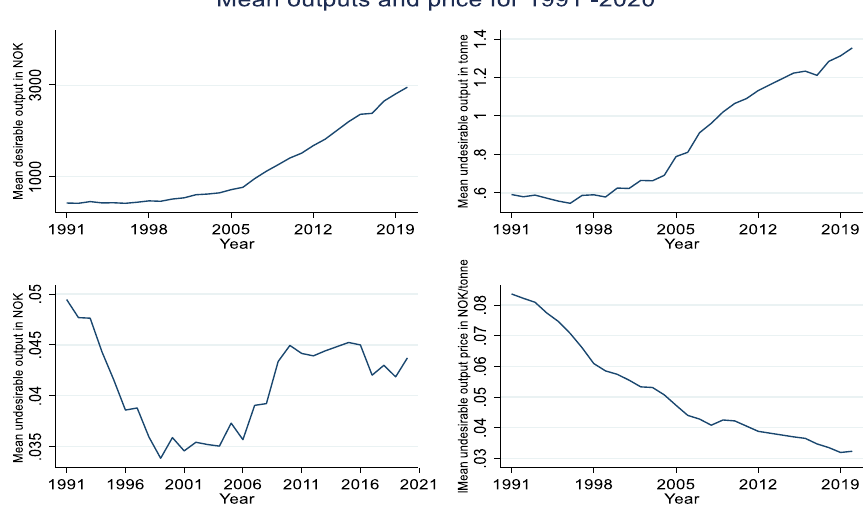
Fig. 1 Annual mean desirable and undesirable output from 1991 to